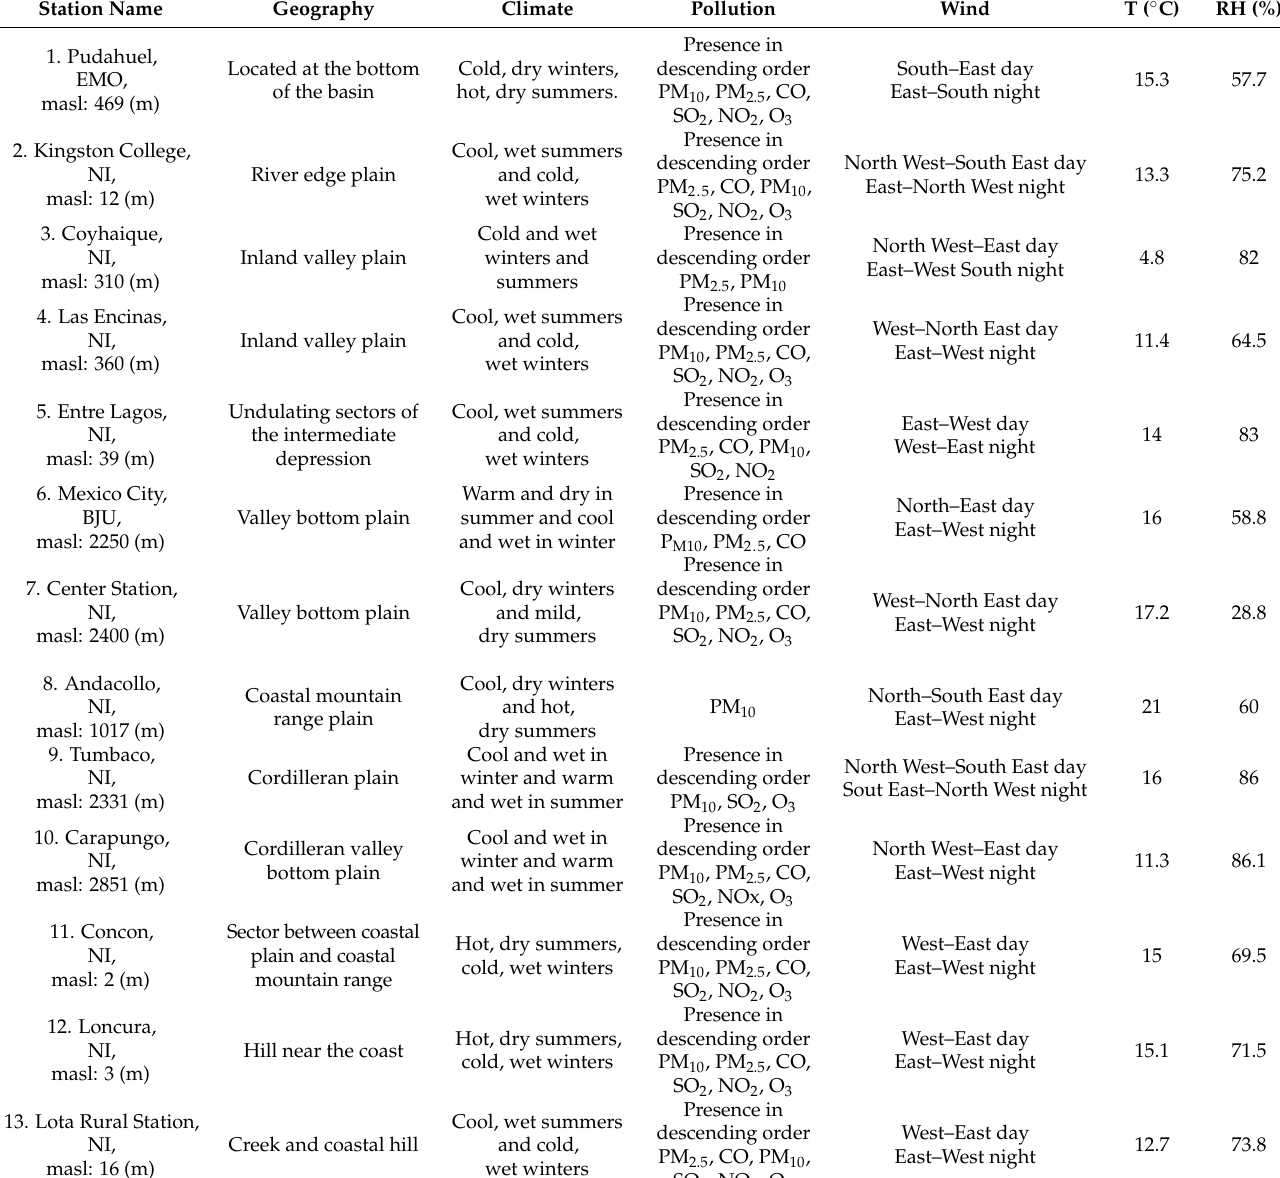
Table 2. The measurement locations, shown in Figure 7, and their specifications. Some with locality code and others not informed (NI), meters above sea level (masl), geography, pollutants and meteo- rology (Wind, average annual temperature (T) and average annual relative humidity (HR%))